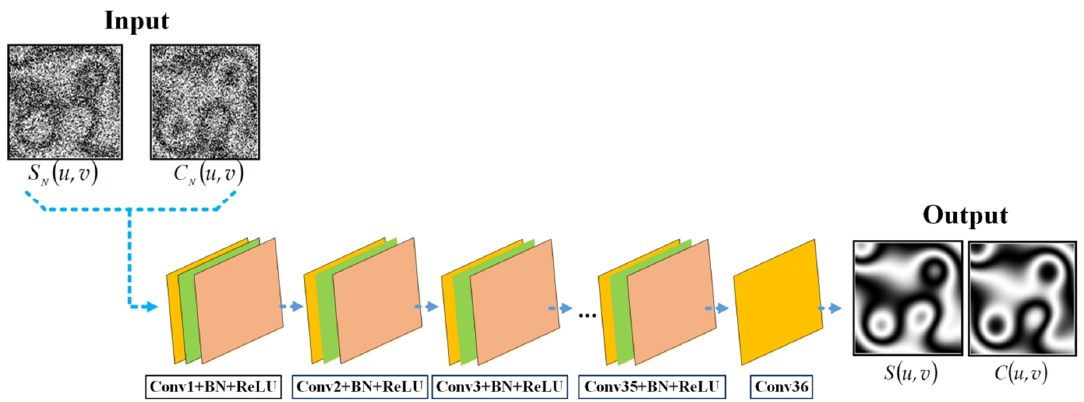
Figure 4. The architecture of the proposed network.